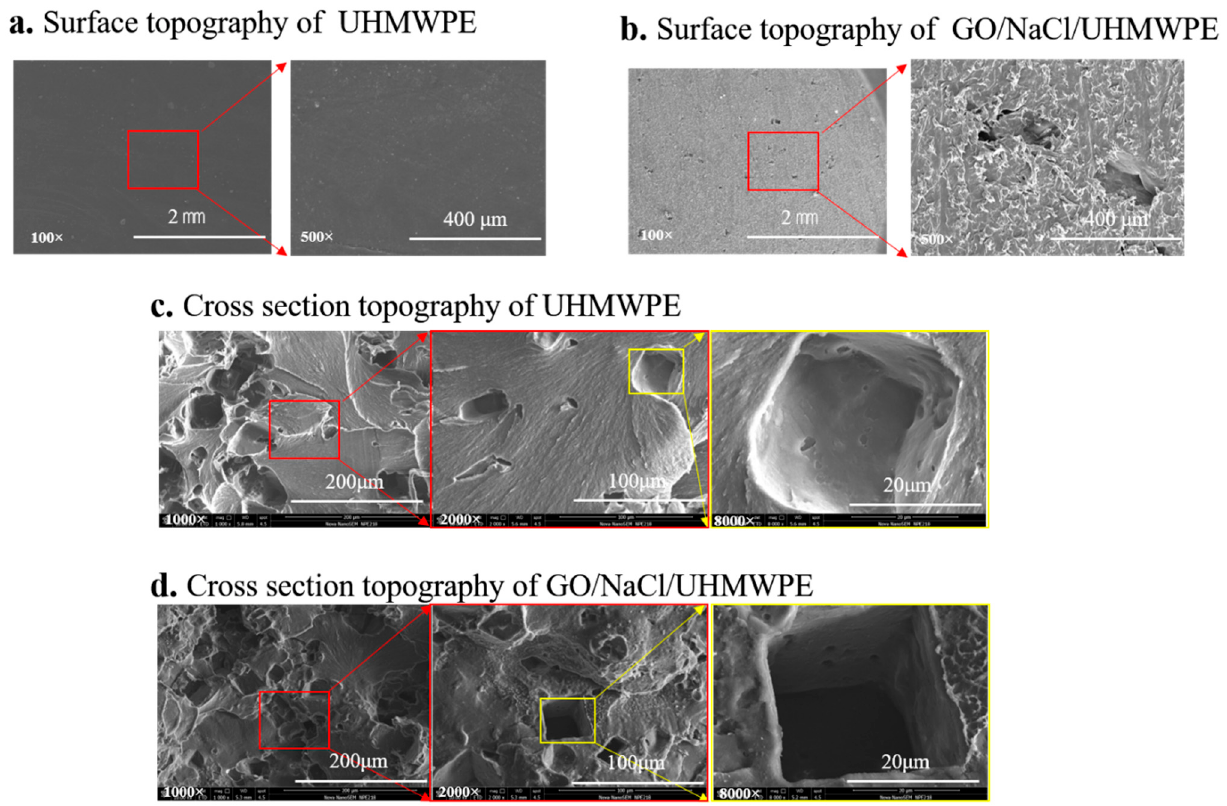
Figure 4. SEM of the surface and cross-section of UHMWPE and surface porous GO/UHMWPE composites.